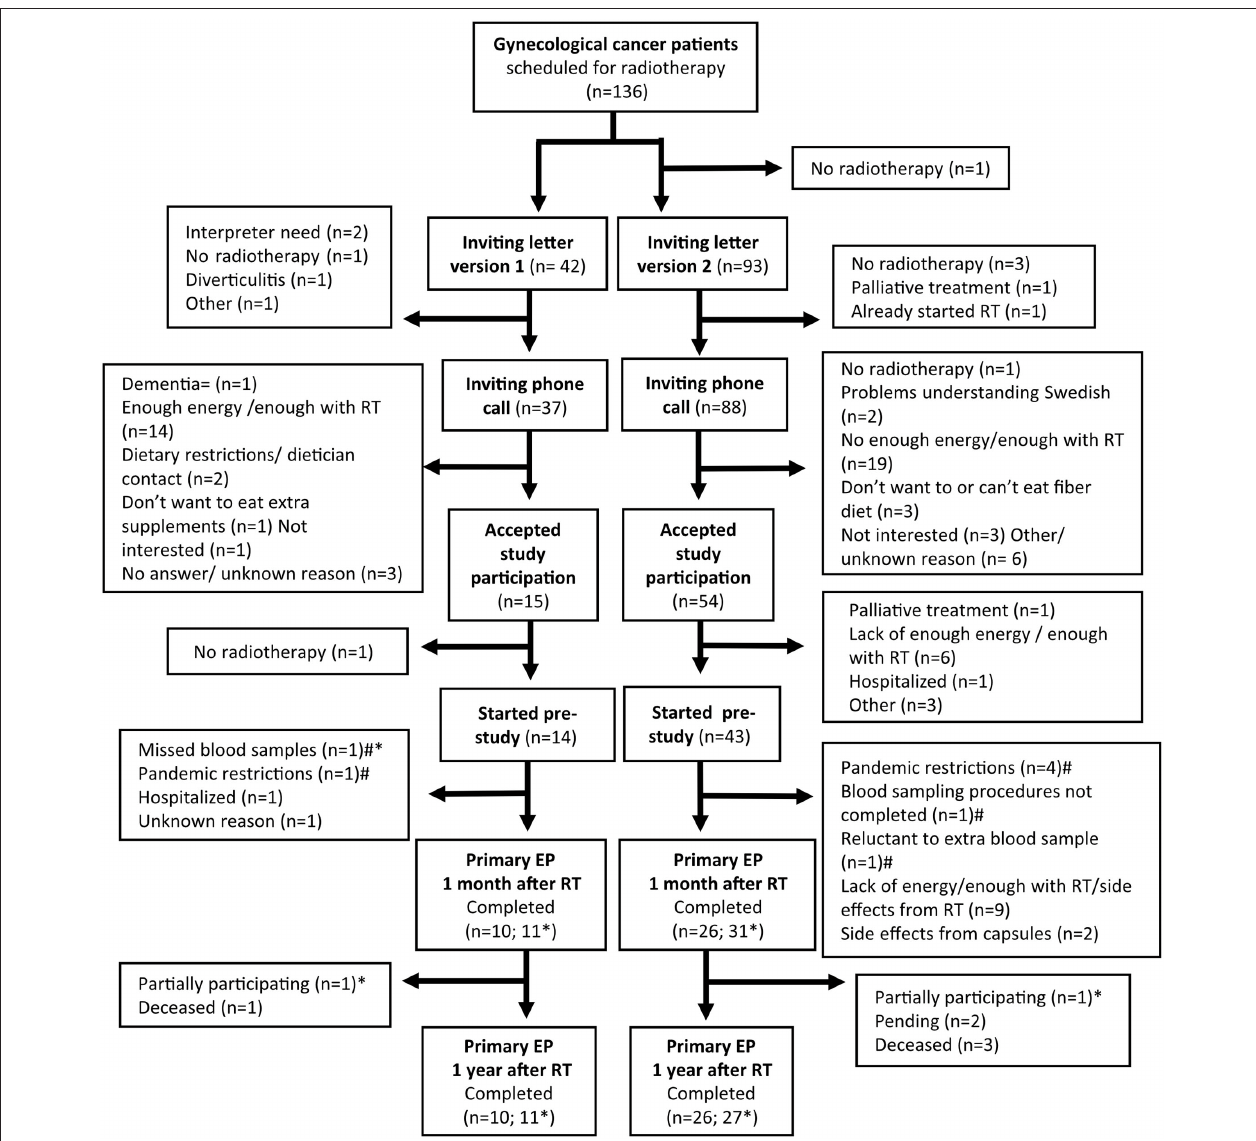
FIGURE 2 | Flowchart of the preparatory study. RT, Radiotherapy; EP, endpoint. The third blood sample was the primary endpoint 1 month after radiotherapy and the third questionnaire was the primary endpoint 1 year after radiotherapy. *Completed either blood sample, fecal sample, or questionnaire. # Continuing preparatory